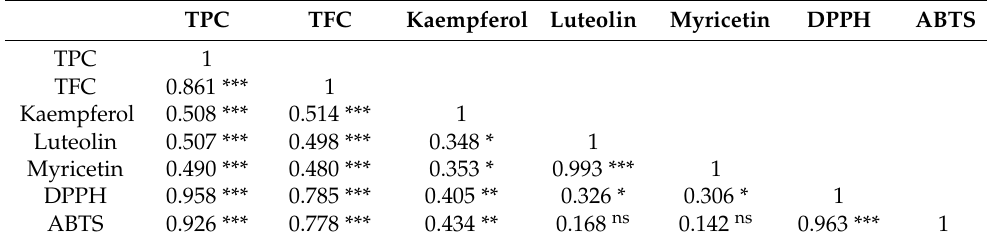
Values marked with asterisks indicate significance by Pearson’s correlation analysis. * indicates p < 0.05, ** indicates p < 0.01, *** indicates p < 0.001, and ns indicates no